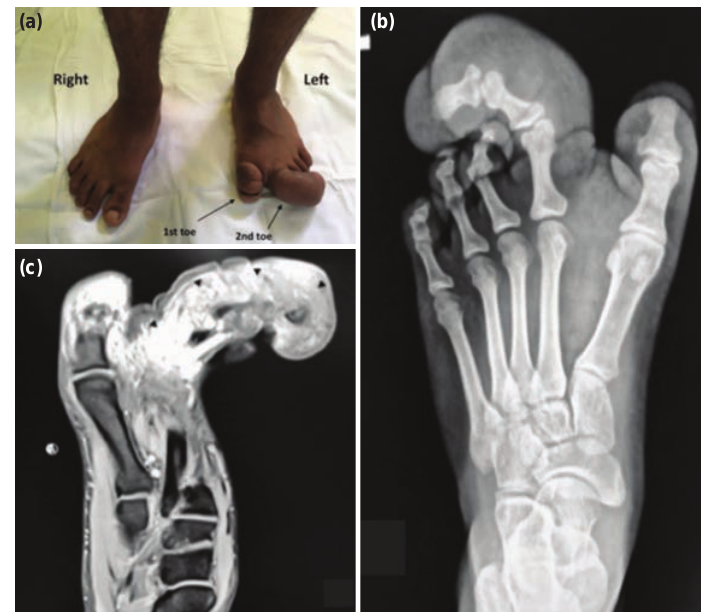
Clinical and radiological features of MDL (a) Clinical features of overgrowth of left 1st and 2nd toe. (b) Radiograph of MDL Fig. 1: showing a laterally deviated 2nd toe with enlarged phalanges and soft tissue overgrowth. (c) Sagittal view of T1 weighted MRI of the foot showing excess subcutaneous tissue of the 2nd toe (arrowhead).